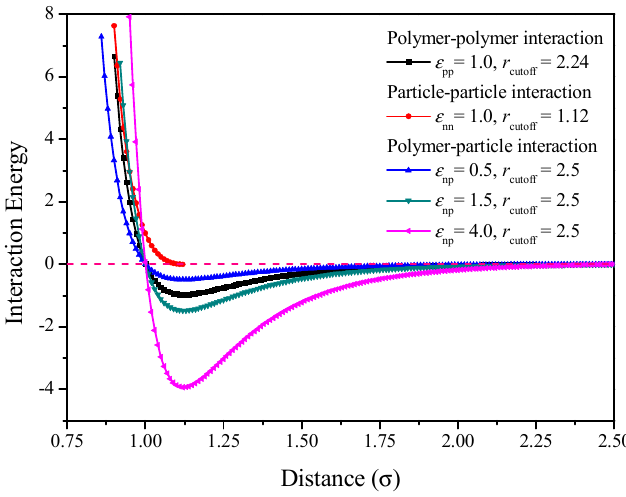
Figure 2. Plot of interaction energy versus distance for various interaction parameters.